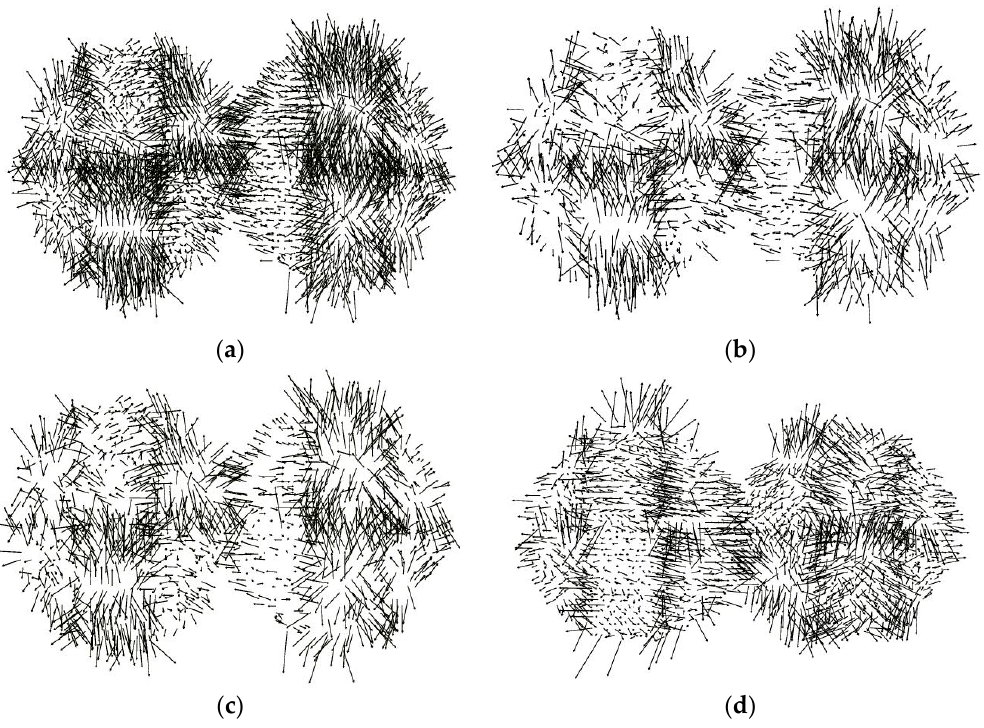
Figure 10. Vector diagrams of the atomic displacement when different systems start to melt. ( a ) The alloy particle starts to melt, ( b ) Ti atoms when the alloy particle starts to melt, ( c ) Al atoms when the alloy particle starts to melt, ( d ) the elemental mixed powder particle starts to melt (Ti on the left, Al on the right).